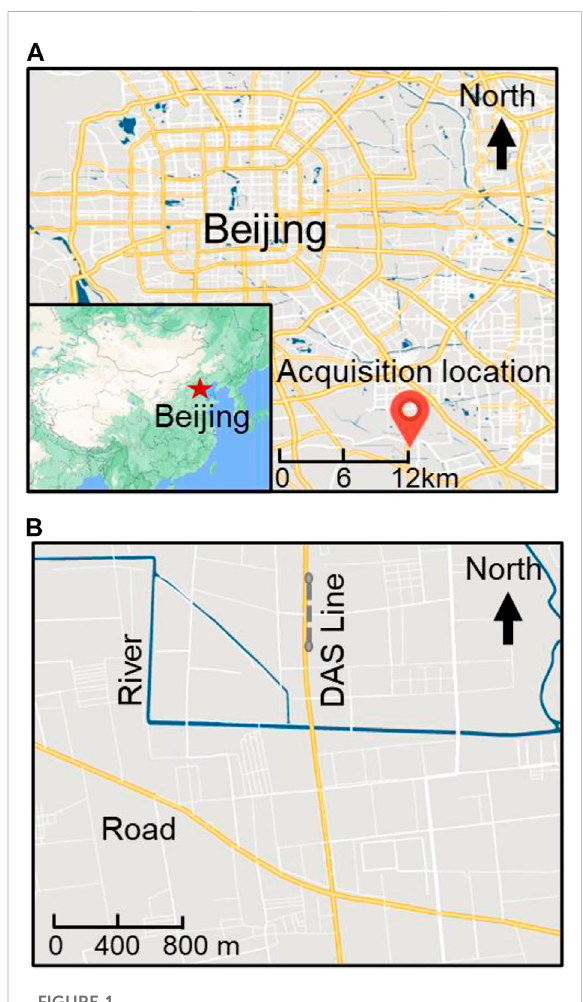
FIGURE 1 (A) LocationofthedataacquisitionareainBeijing,China. (B) A zoomed-in view of the fi eld acquisition layout. The dashed gray line indicates the DAS line along the